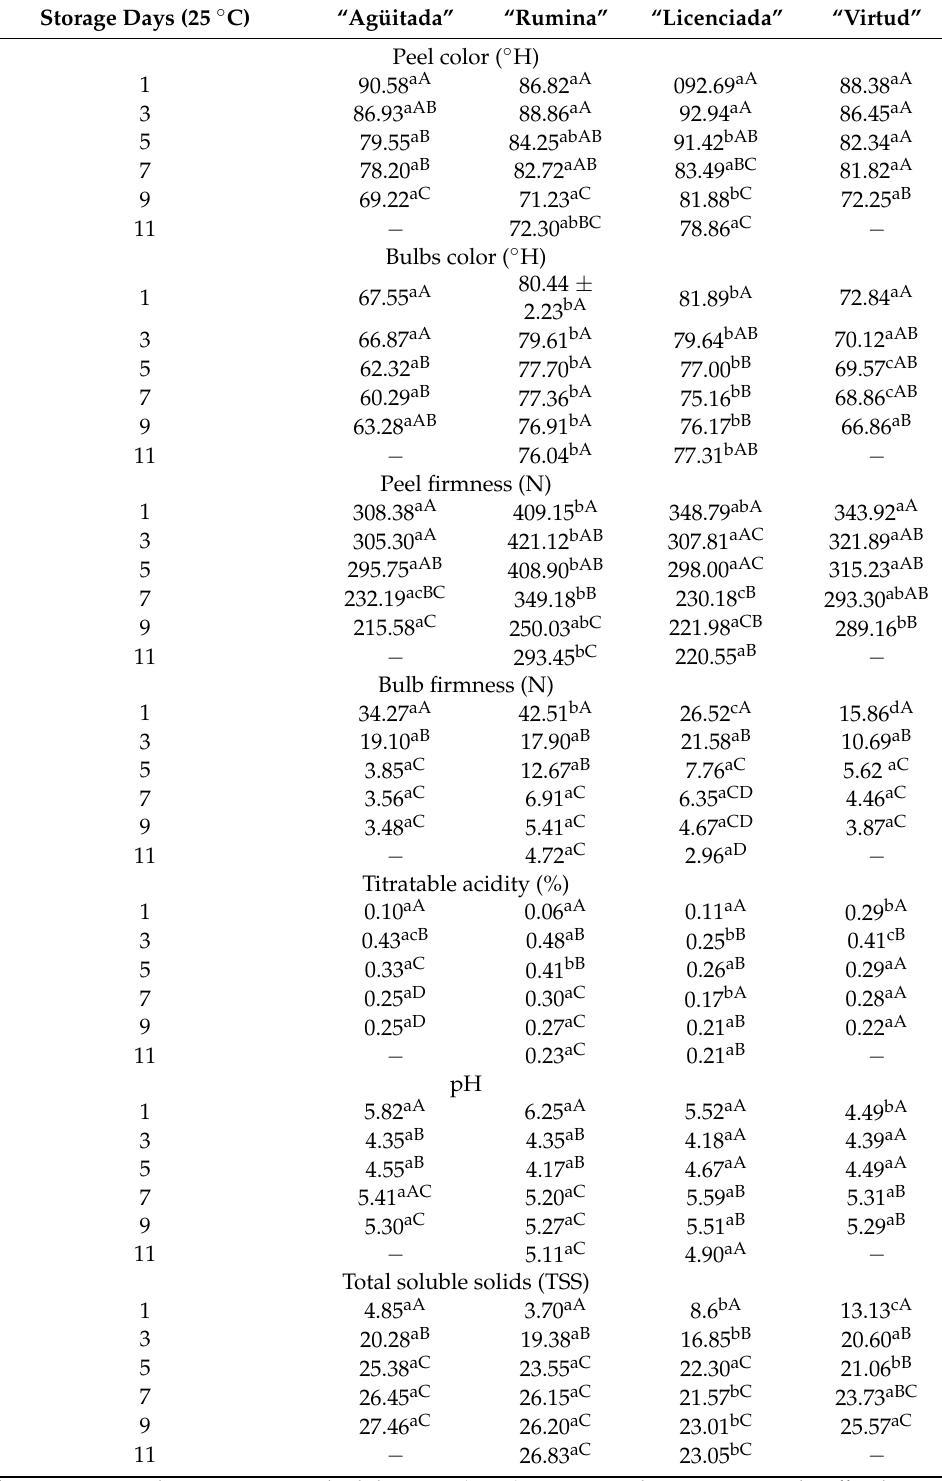
Table 3. Physicochemical Analysis of Peel and Bulbs of Jackfruit